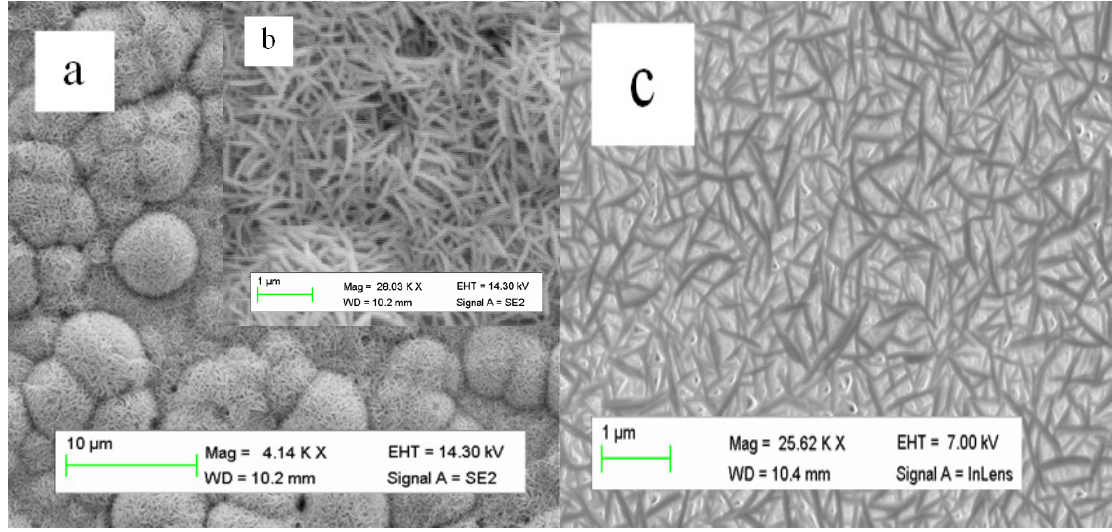
Figure 2. Scanning electron microscopy (SEM) images of ZnS nanomaterial: ( a ) low magnification, ( b ) high magnification, ( c ) effect of higher concentration of cetyltrimethyl ammonium bromide cationic